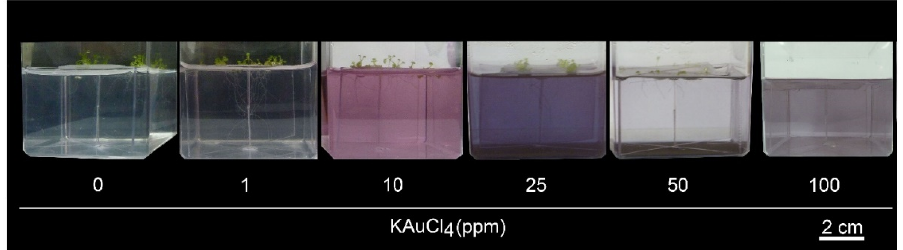
Figure 2. A low dosage of KAuCl 4 triggers augmented the growth of Arabidopsis seedlings. Wild- type Arabidopsis seedlings were hydroponically grown in a nutrient-rich (NR) medium for 7 d and then transferred to an NR medium supplemented with 0, 1, 10, 25, 50, and 100 ppm KAuCl 4 and grown for a further 7 d. Dosage-dependent effects of KAuCl 4 on the development responses of the root and shoot were documented.